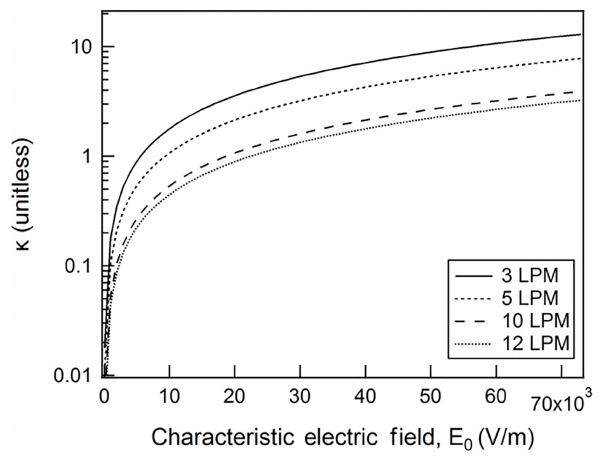
Figure 2. κ versus voltage (V) for a range of velocities that sat- isfy the AC-CIMS design requirements, using prototype geometry. Particle diameter 30nm.